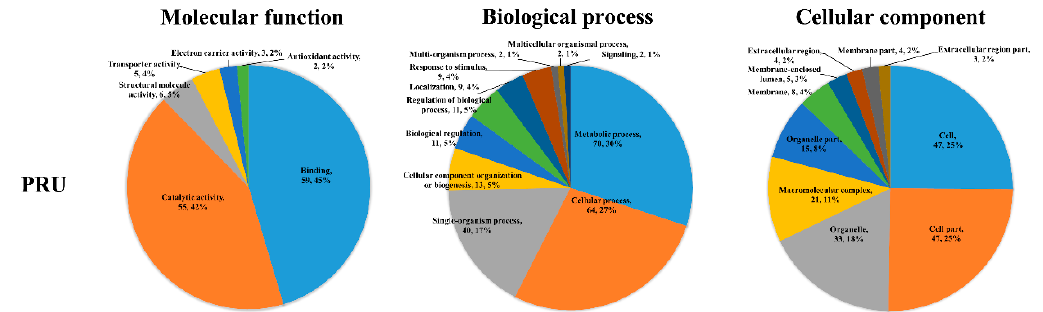
Figure 9. GO enrichment analysis of the di ff erentially acetylated proteins (DAPs) in PRU strain. Functional classification of acetylated proteins in each strain according to the categories of molecular function, biological process, and cellular component. The numbers of DAPs and percentages of DAPs in relation to the total acetylated proteins involved in specific GO terms are shown.